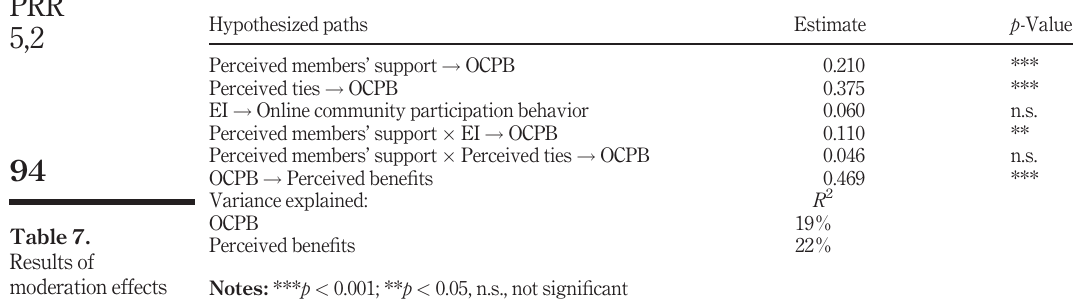
Table 7. Results of moderation